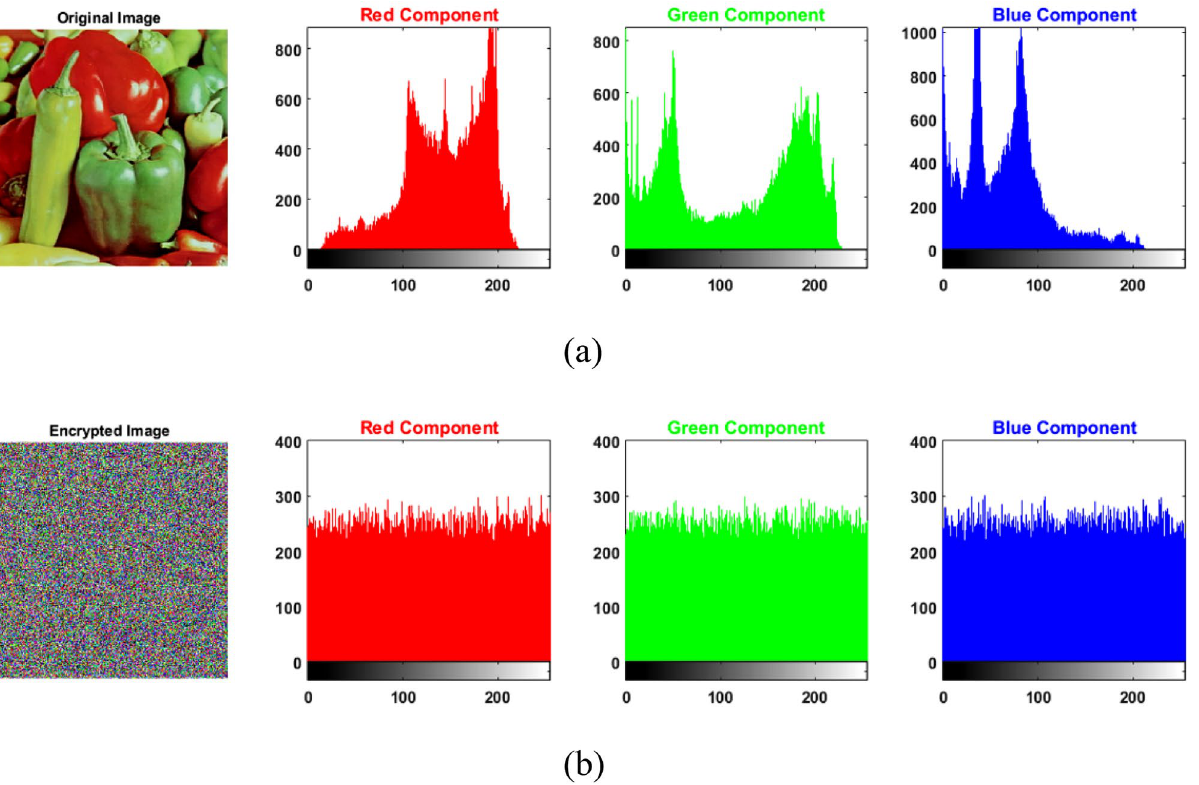
Figure 10. Histograms for the three-color channels in ( a ) Peppers and ( b ) encrypted Peppers.